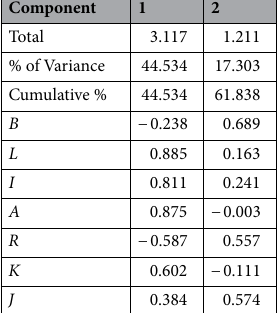
Table 1. Calculation results of topographic factor principal component analysis